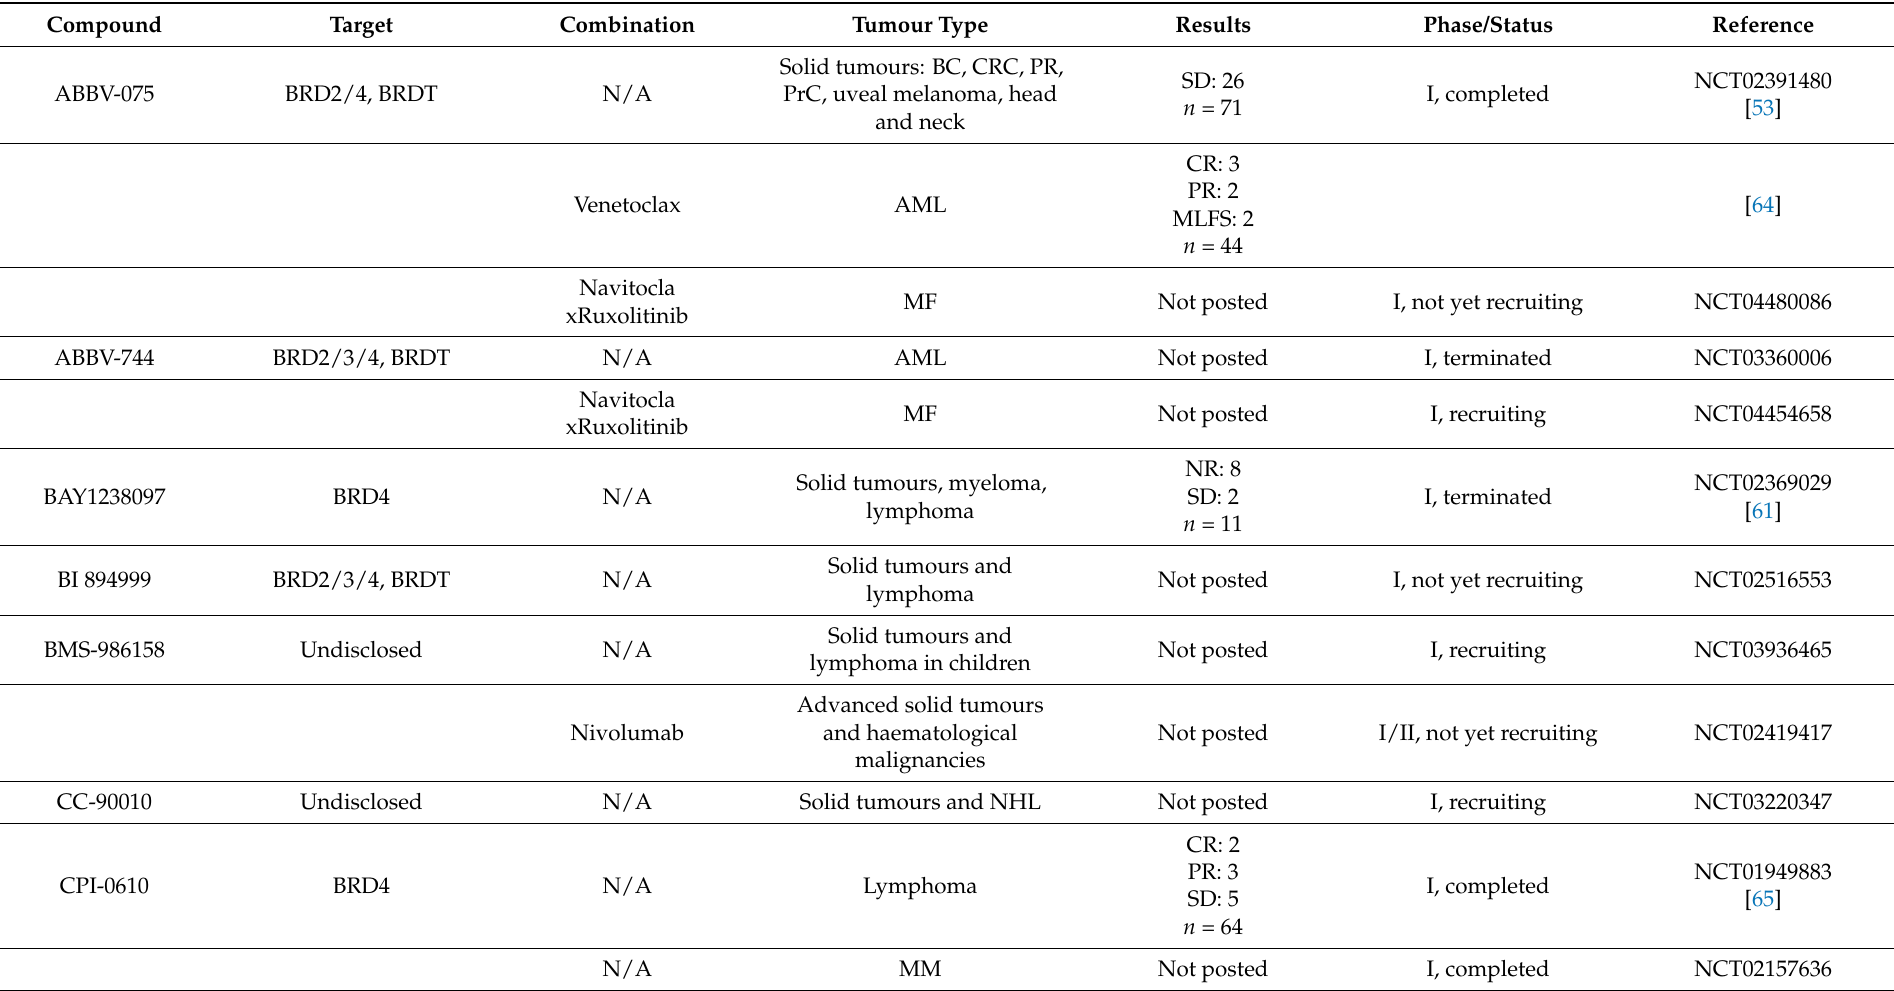
Table 1. BET inhibitors in clinical